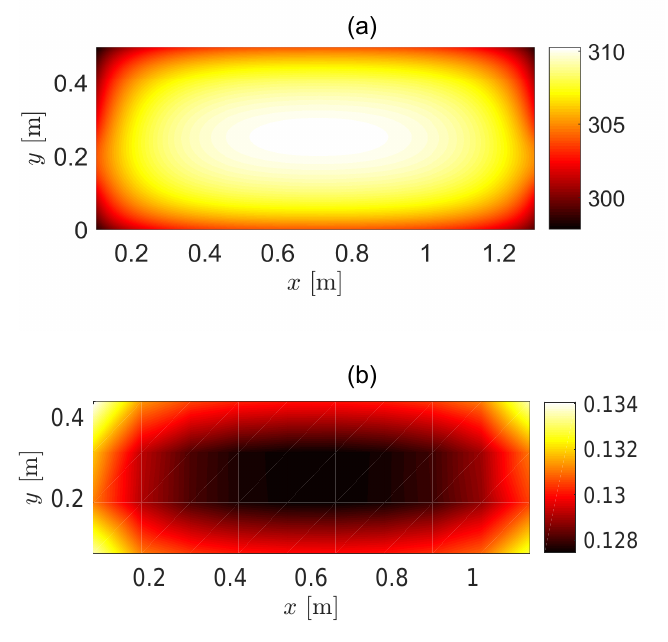
Figure 5. Spatial distribution of ( a ) the cell temperature, T c , and of ( b ) the electrical performance, η , for ˙ v = 0 L/h.